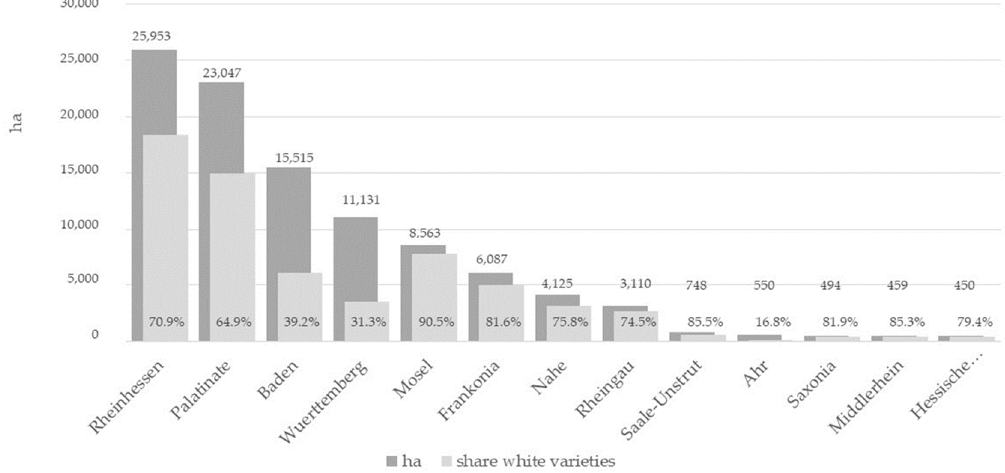
Figure 2. Wine regions by planted surface, and the white wine proportion thereof (2017) [55].